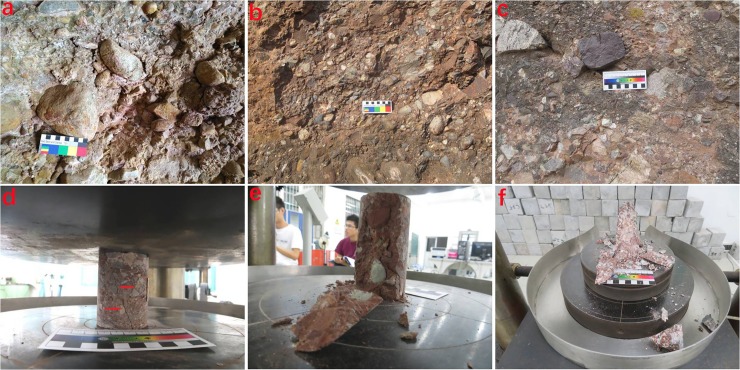
Photographs of lithological differences and morphologies of rock samples after rock failure.(a) Cretaceous strata lithology, (b) Triassic strata lithology, and (c) Permian strata lithology. Post-rock failure morphology of (d) the Cretaceous rock sample from Hudiedong Cave, (e) the Triassic rock sample form Mt. Elephant, and (f) the Permian rock sample from Mt. Taitongshan.